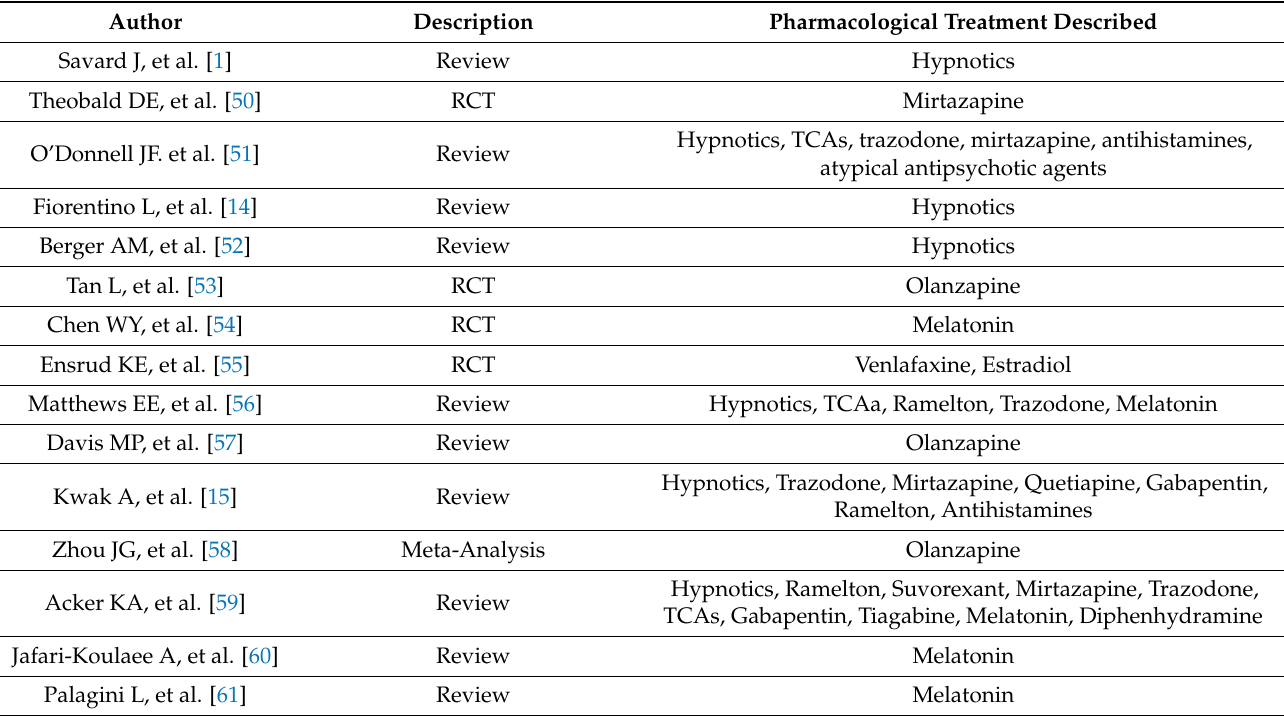
Table 1. RCTs, systematic reviews, and meta-analyses on the pharmacological treatment of insomnia in cancer